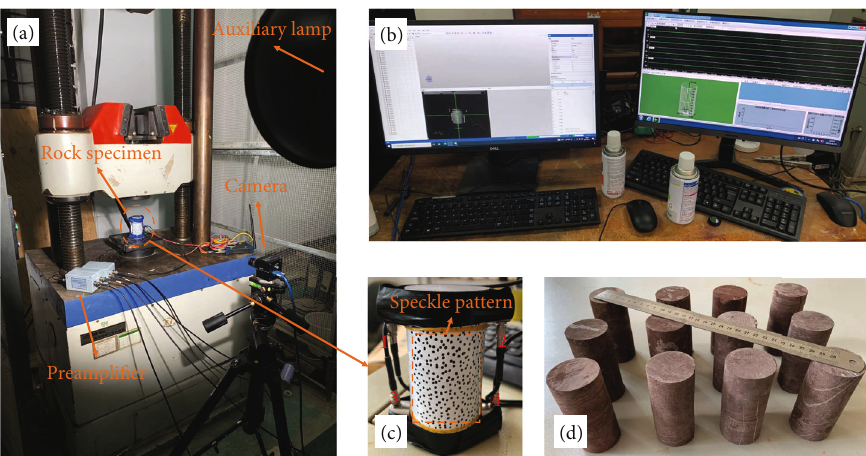
Figure 2: (a) Photo of the test setup. (b) DIC desktop (left) and AE desktop (right). (c) Argillaceous siltstone with speckle pattern and the locations of the attached AE sensors (from 1 to 4). (d) Argillaceous siltstone specimens. Table 1: Moisture content of argillaceous siltstone at di ff erent soaking